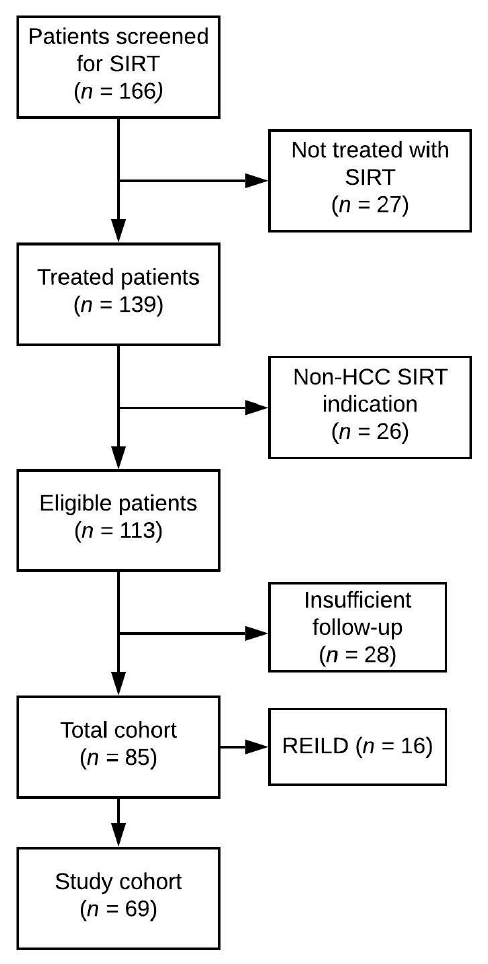
Figure 1. Inclusion flowchart. SIRT: Selective Internal Radiation Therapy; Non-HCC: Patients who un- derwent SIRT for clinical indications other than hepatocellular carcinoma; REILD: Radioembolization- induced liver disease.